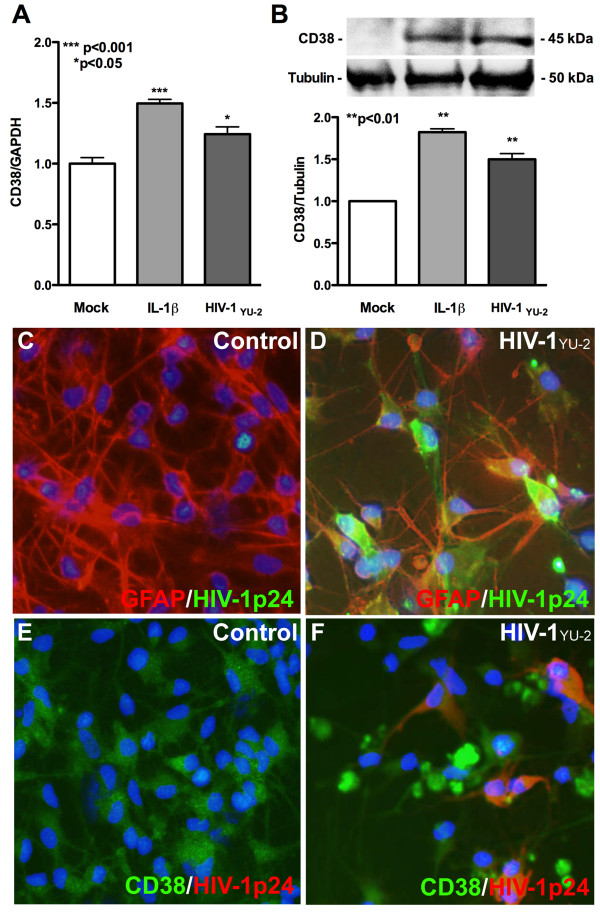
Astrocyte HIV-1YU-2-transfection increases CD38 expression. Cultured human astrocytes were transfected with HIV-1YU-2 plasmid and mock-transfected controls were maintained in parallel. RNA was isolated 24 h post-transfection and assayed for CD38 levels. (A) By real-time-PCR assay, significantly higher CD38 mRNA levels were detected in HIV-1YU-2-transfected astrocytes as compared to mock controls (p < 0.05). (B) HIV-1YU-2-transfected astrocytes showed significantly increased CD38 protein levels as compared to mock controls when assayed by western blot and densitometry analyses of whole cell protein lysates (p < 0.01), 5 days post-transfection. IL-1β (20 ng/ml)-treated astrocytes were maintained as positive controls for increase in CD38 mRNA and protein levels. Graph shows representative data from two independent donors. Expression of CD38 and HIV-1p24 was measured by immunocytochemistry 5 days post-transfection (C-F). Nuclei were stained in blue by DAPI in all panels. (C) Mock, GFAP-positive astrocytes (red) with no HIV-1p24 expression. (D) Co-localization (yellow) of GFAP (green) and HIV-1p24 (red) in HIV-1YU-2-transfected astrocytes. Transfection efficiency was routinely 90% as assessed by GFAP, HIV-1p24 co-localization (data not shown) (E) Basal CD38 expression (green) and no HIV-1p24 expression in mock control. (F) Increased CD38 expression (green) and co-localization (yellow) with HIV-1p24 (red) in HIV-1YU-2-transfected astrocytes. Original magnification x200.